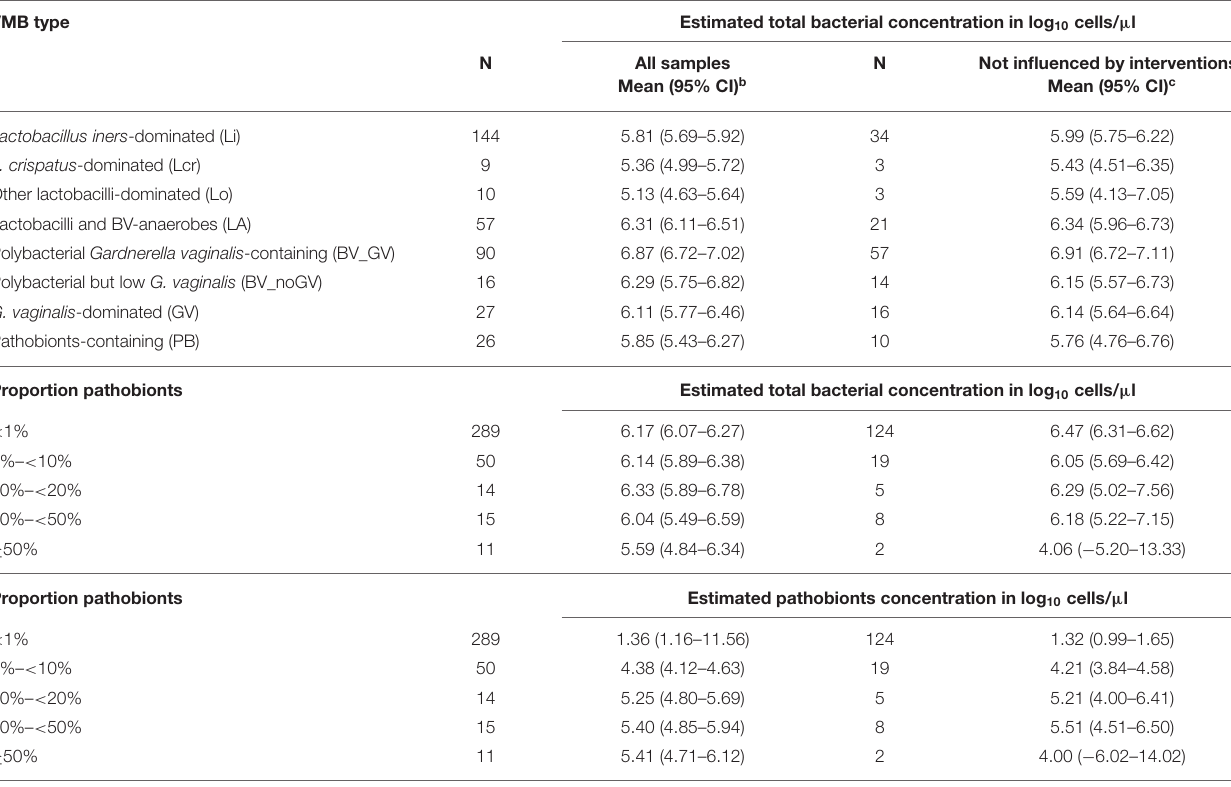
TABLE 4 | Estimated bacterial concentration per VMB type and by proportion of pathobionts (Rwanda VMB study only, multiple samples per